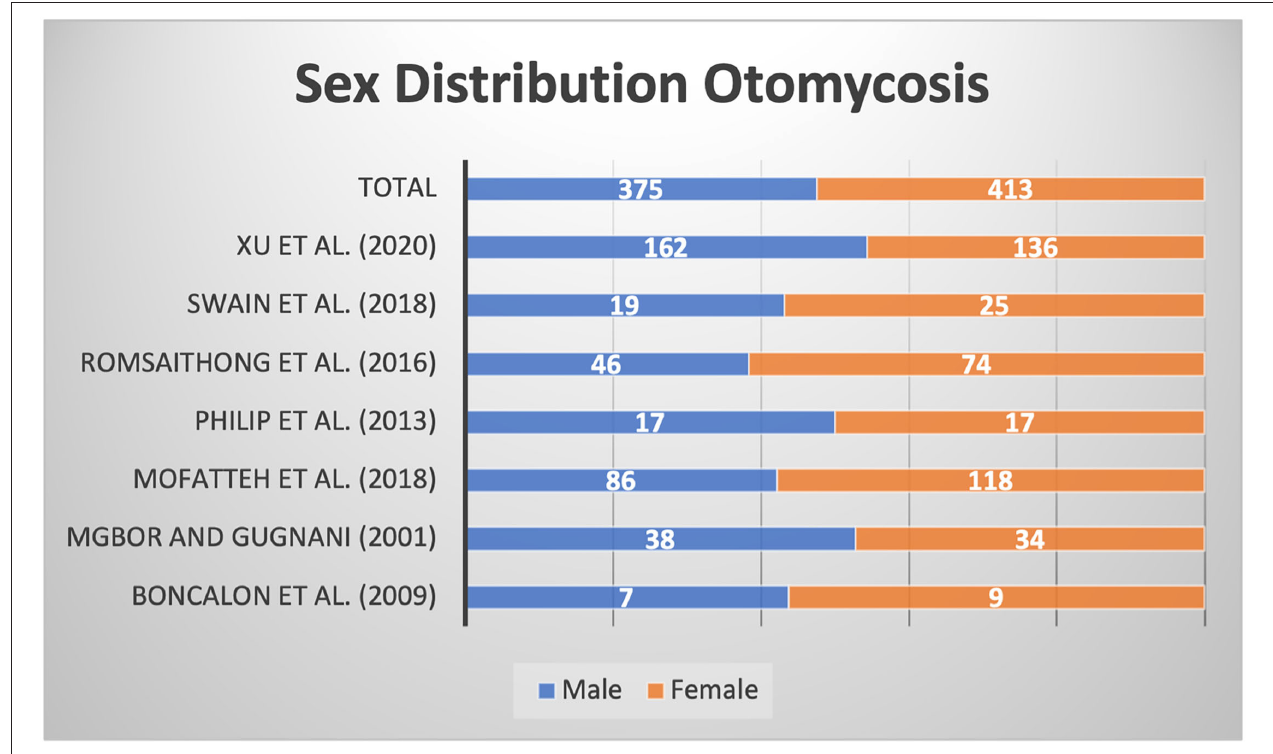
FIGURE 4 | Sex ratios in the included